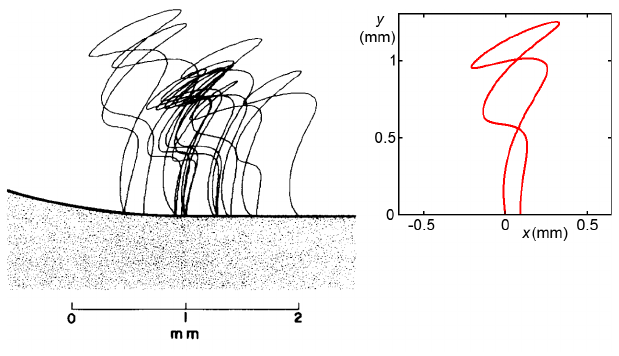
FIG. 6. Analytically found borders of MP1 bands for the geometry